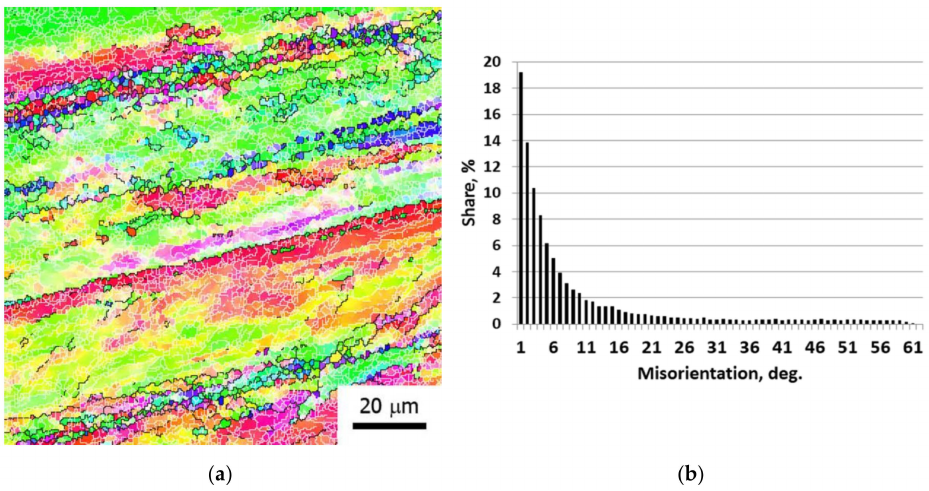
Figure 7. EBSD analysis: ( a ) orientational map after ECAP with wire forming and aging and ( b ) the bar chart of angle misorientation